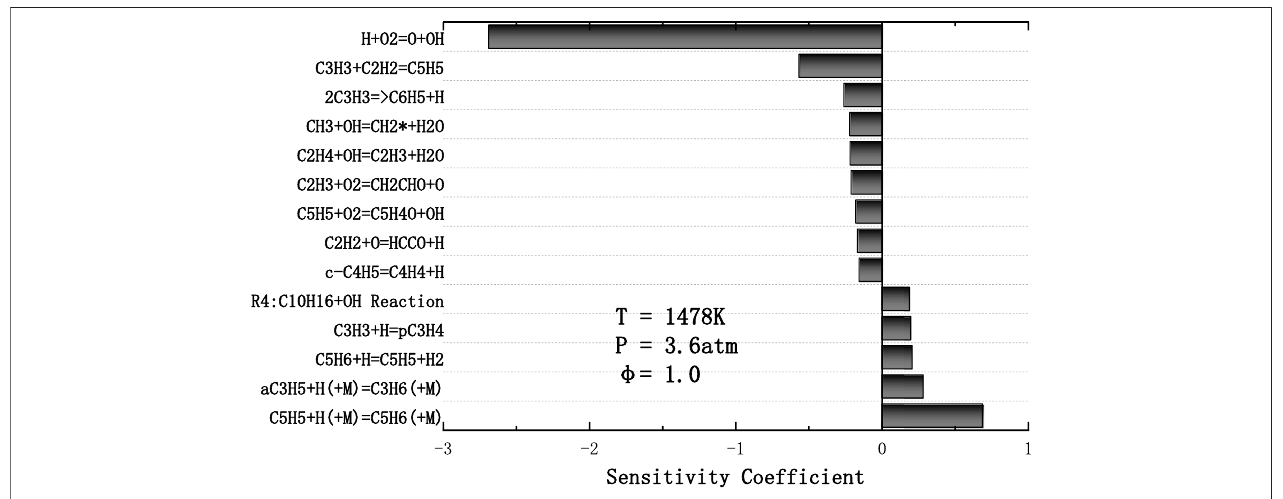
FIGURE10| Normalizedsensitivitycoef fi cientsinpredictingignitiondelaytimeofJP-10/O 2 /ArmixtureforT=1478 K, p =3.6 atm, φ =1.0calculatedwithHychem detailed mechanism.